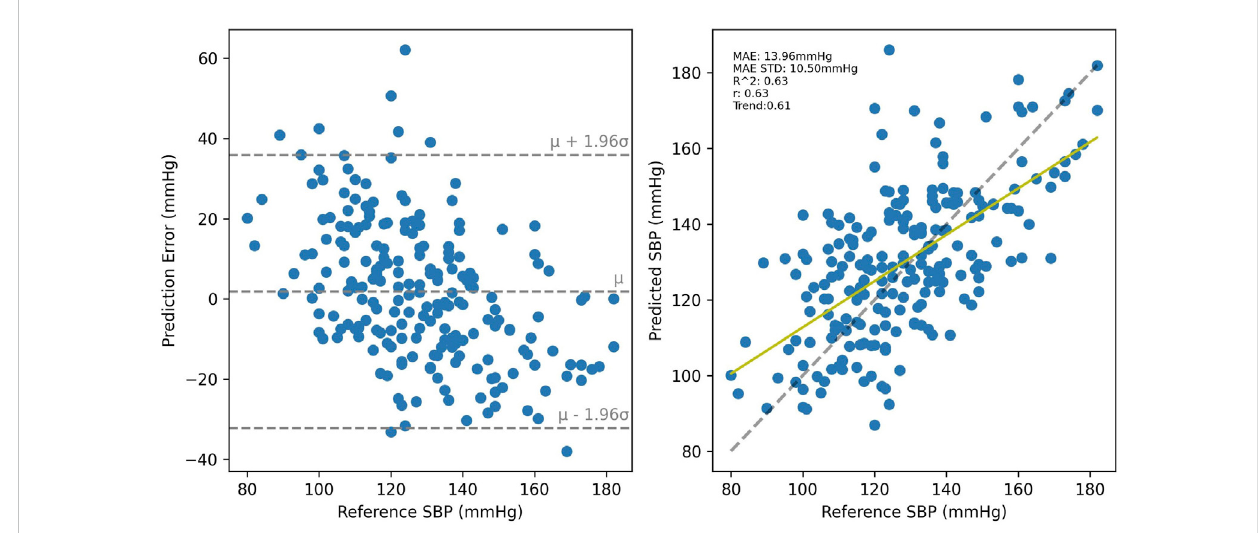
FIGURE 8 Cross validated results for the PPG-BP trained model.